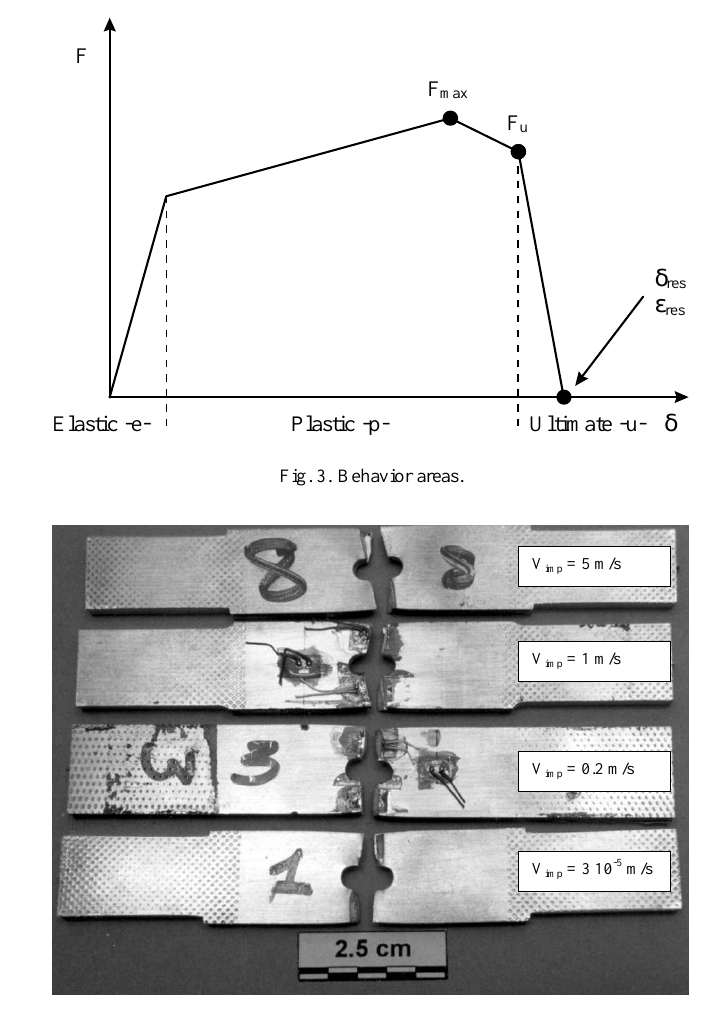
Fig. 4. Experimental patterns of punched tension